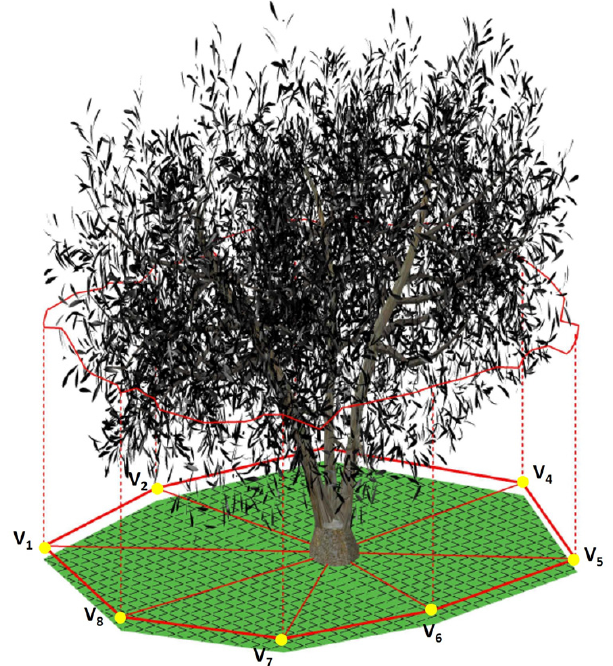
Figure 2. Mean vector (MV) measurements: vectors 1–8 are measured from the trunk to the outermost part of the tree crown in 8 fixed directions.